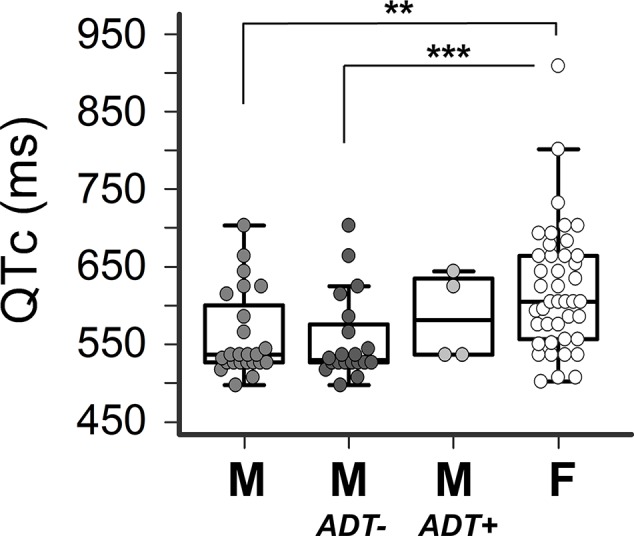
Impact of sex and androgen deprivation therapy on QTc in TdP patients. Comparisons of QTc in males (M, n=24), males untreated with androgen deprivation therapy (M-ADT-, n=20), males treated with androgen deprivation therapy (M-ADT+, n=4), and females (F, n=42). ***p < 0.001, **p < 0.01; M-ADT+ vs F: p=0.38; M-ADT- vs M-ADT+: p=0.14. All comparisons were performed by the two-tails Mann-Whitney test: QTc: heart-rate corrected QT interval; TdP: Torsades de pointes.